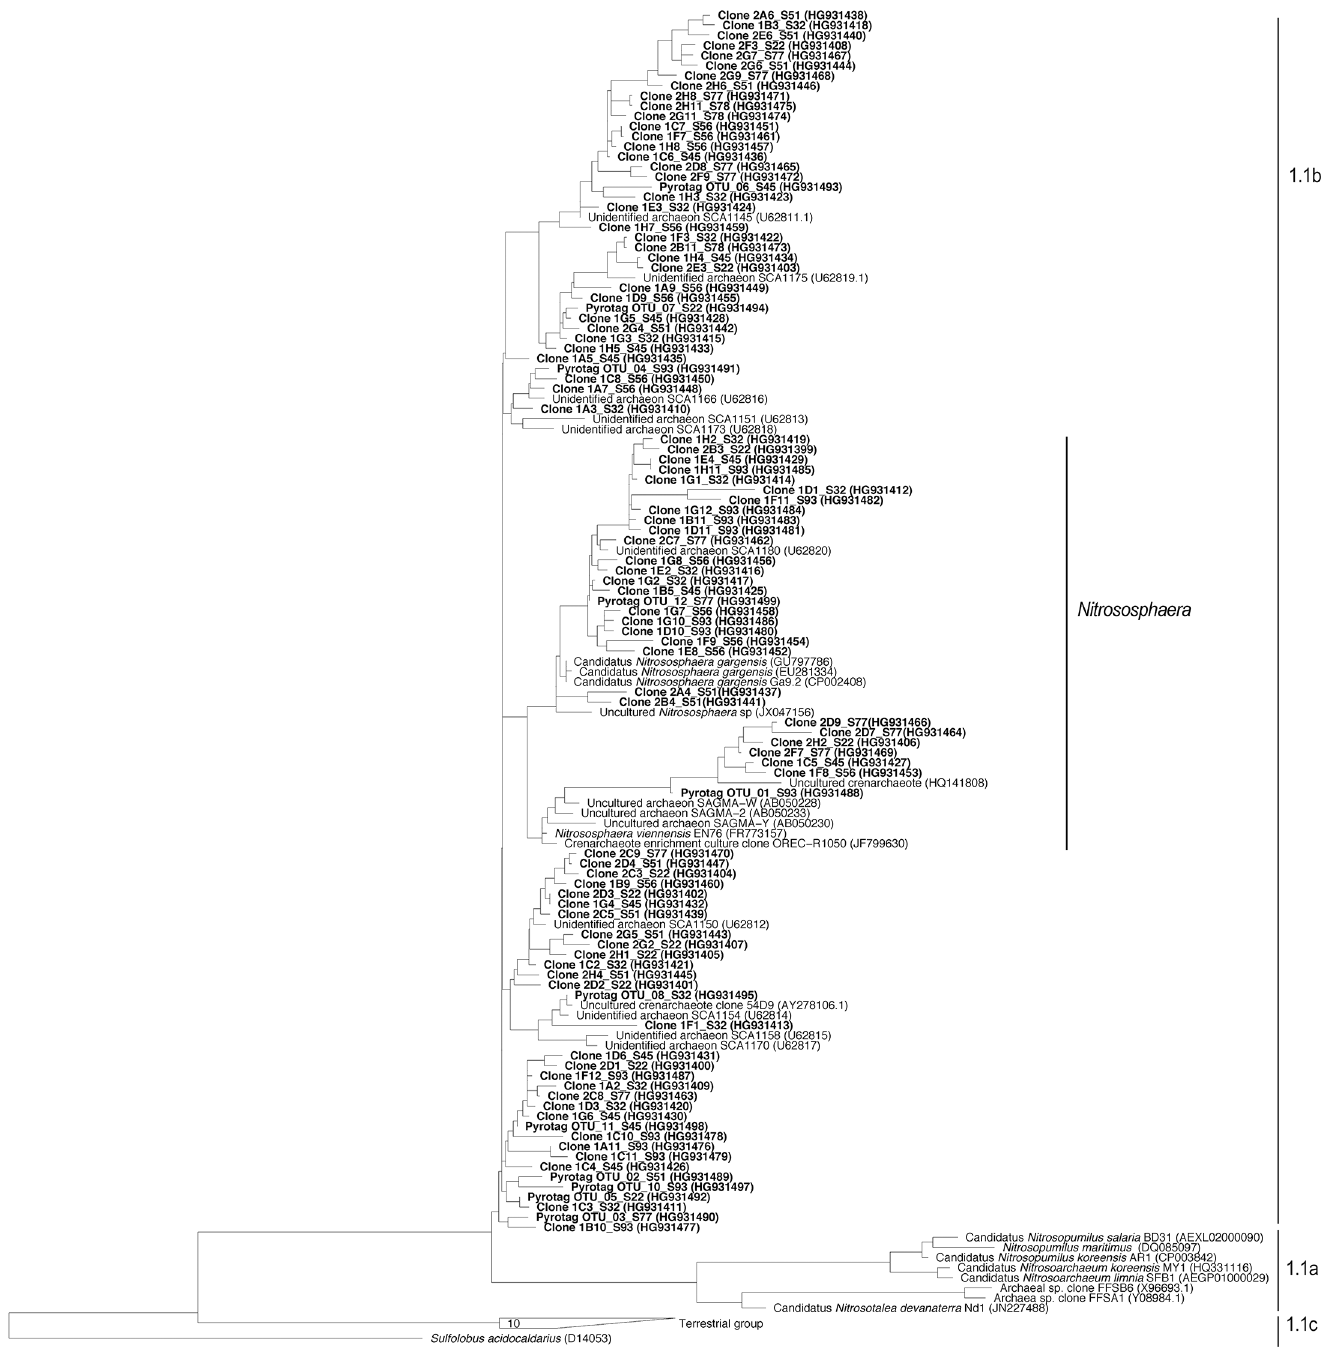
Fig 3. Maximun likelihood phylogenetic tree for the 16S rRNA gene of Thaumarchaeota 1.1b (soil crenarchaeotic group, SCG), including the Nitrososphaera -like clade. Partial sequences (c. 220 and 550 bp, bold-faced) were inserted in the original tree by maximum parsimony keeping the overall tree topology. Bar scale: 5%